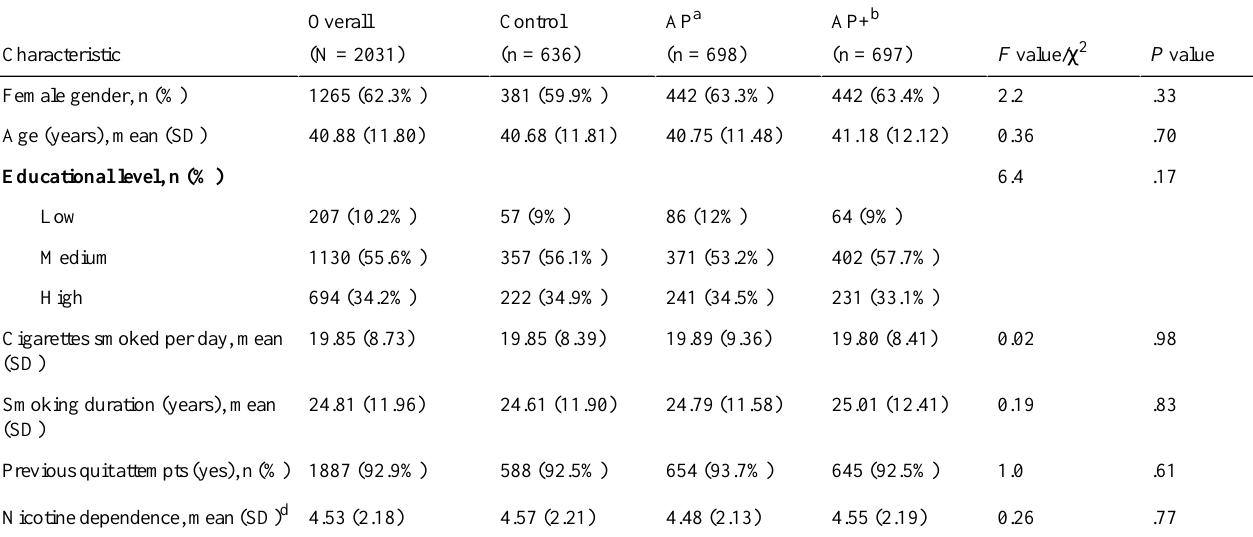
Table 1. Means and baseline differences between the three programs in demographic and smoking-related